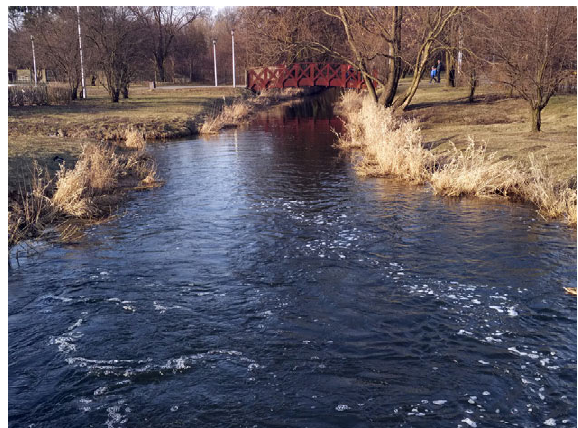
Fig. 4. Utrata River drains the described area; in the photo: the river after leaving Komorów Reservoir. Photo by M. Górska-Zabielska